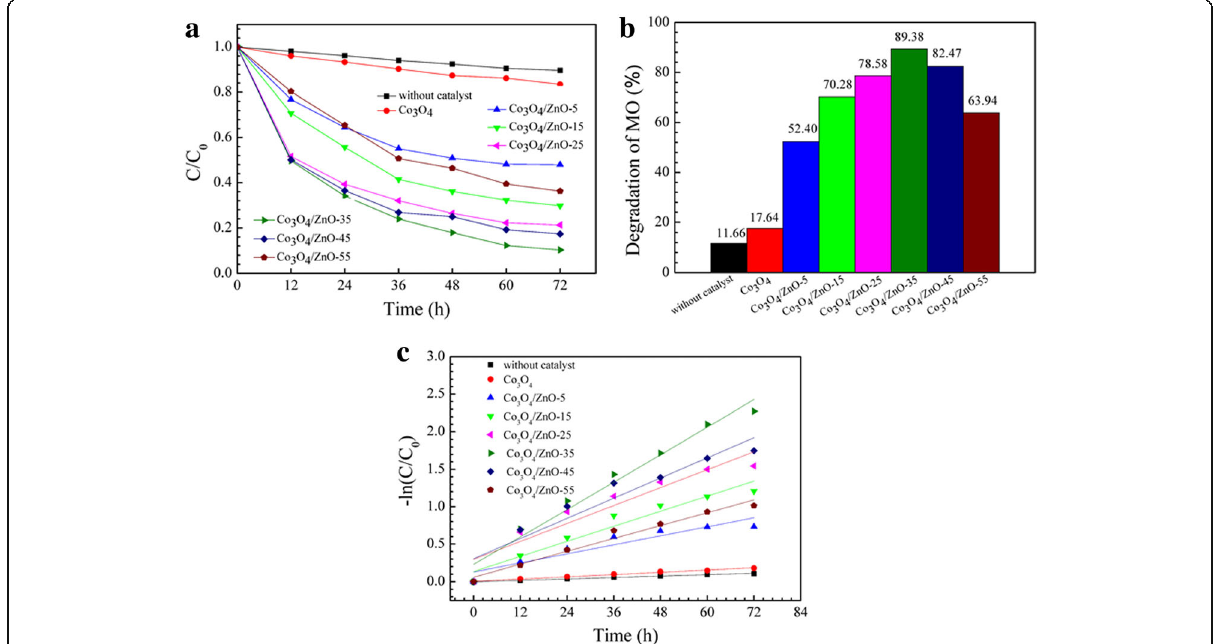
Fig. 11 Photocatalytic activity of pure Co 3 O 4 and the different fabricated p -Co 3 O 4 / n -ZnO heterostructures: a the relative concentration of MO as a function of irradiation time ((C 0 and C are the concentration of MO at initial and any time)), b the degradation efficiency of MO in 72 h, c first- order plot of MO